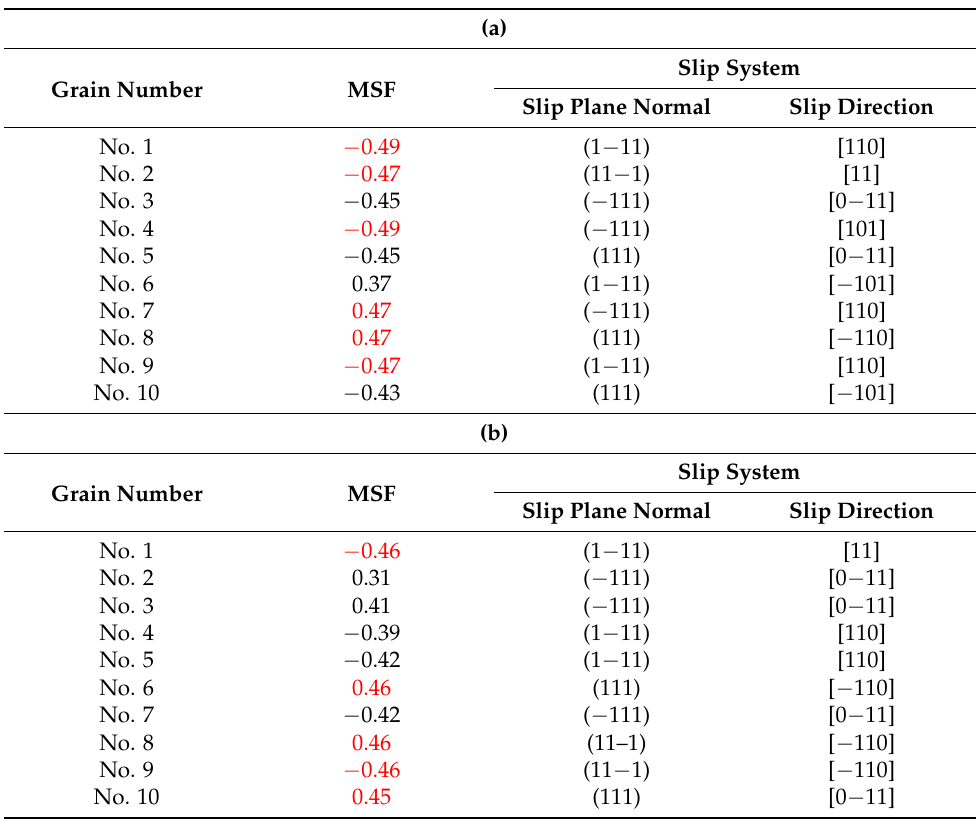
Table 3. Maximum Schmidt factor (MSF) in each grain and slip system, which takes the MSF in Model 1 ( a ) and Model 2 ( b ). MSFs with large absolute values are shown in red